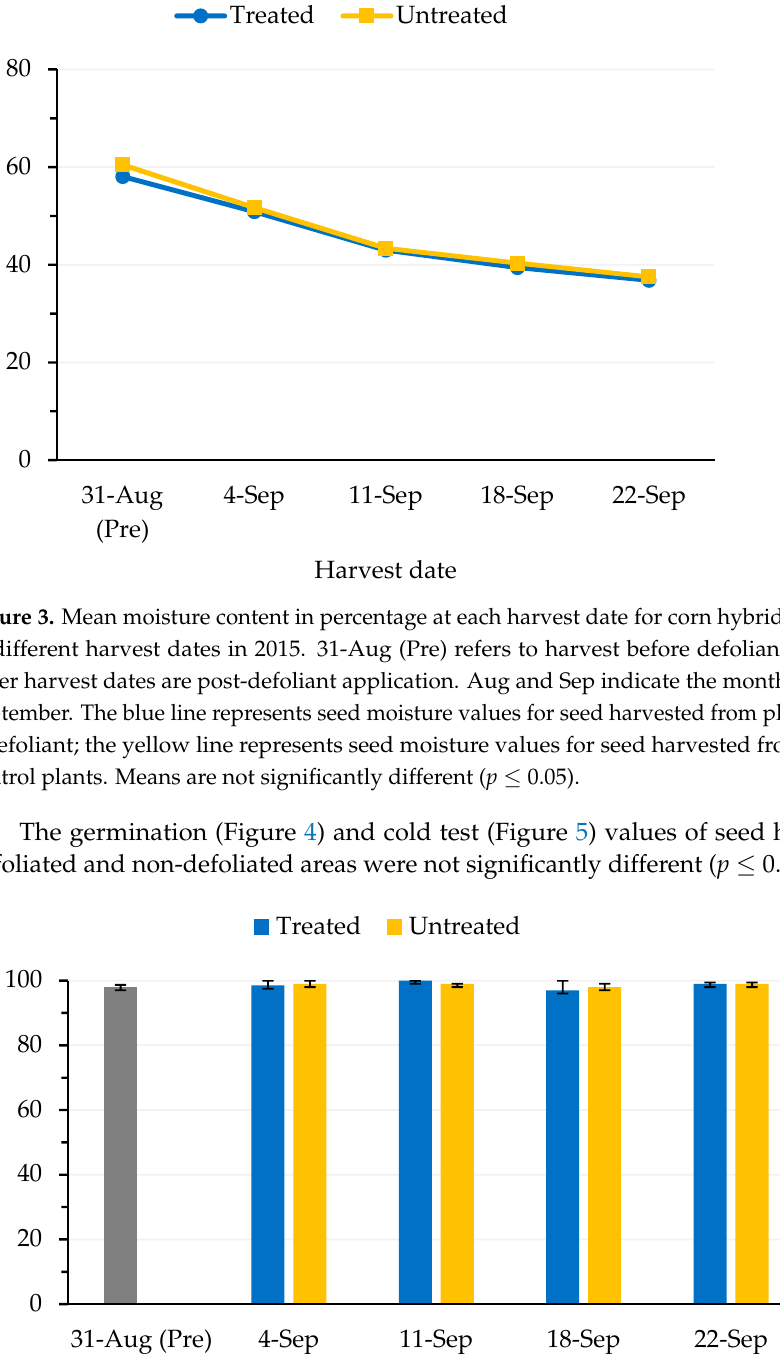
Figure 5 . Mean cold test values in percentage for corn hybrid seeds harvested at different harvest dates in 2015. 31-Aug (Pre) refers to harvest before defoliant application; all other harvest dates are post-defoliant application. Aug and Sep indicate the months of August and September. Blue col- umns are the values for seed harvested from plants treated with a defoliant; yellow columns are the values for seed harvested from the untreated control plants. Bars indicate standard error of the mean ( SEM ). Means are not significantly different ( p ≤ 0.05). 4. D iscussion The US seed corn market is very competitive [16]. Farmers expect rapid and uniform field emergence of their crop under a wide range of environmental conditions. Cold and wet conditions at planting are common in the upper Midwest of the USA [17]. The use of seeds with high physiological potential is essential to achieve rapid and uniform emer- gence under these stressful environmental conditions [18]. Seed physiological potential is